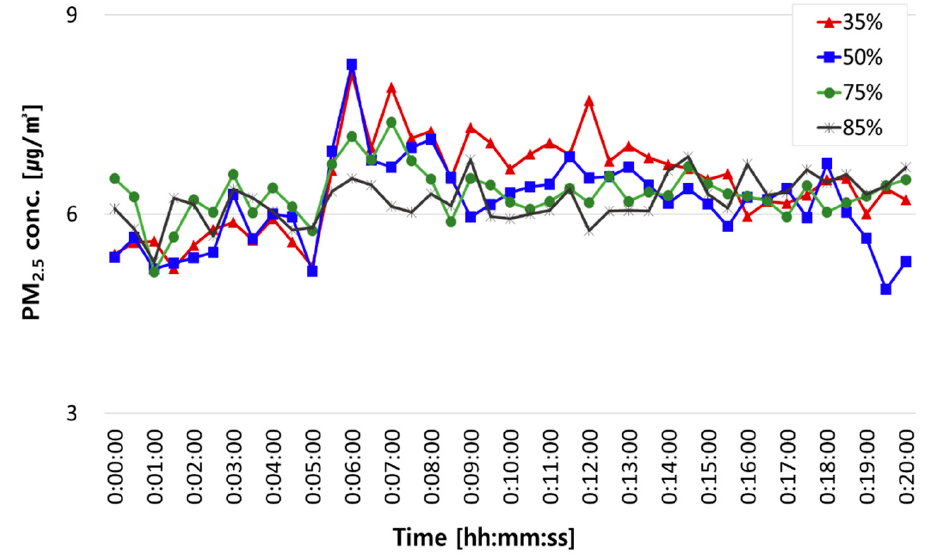
Figure 6. Changes in PM 2.5 concentrations in the classroom chamber under each humidity condition: at 35%, 55%, 75%, and 85% humidity. Table 6. PM resuspension concentrations in the classroom chamber under each humidity condition (the values in bracket represent the standard deviations).